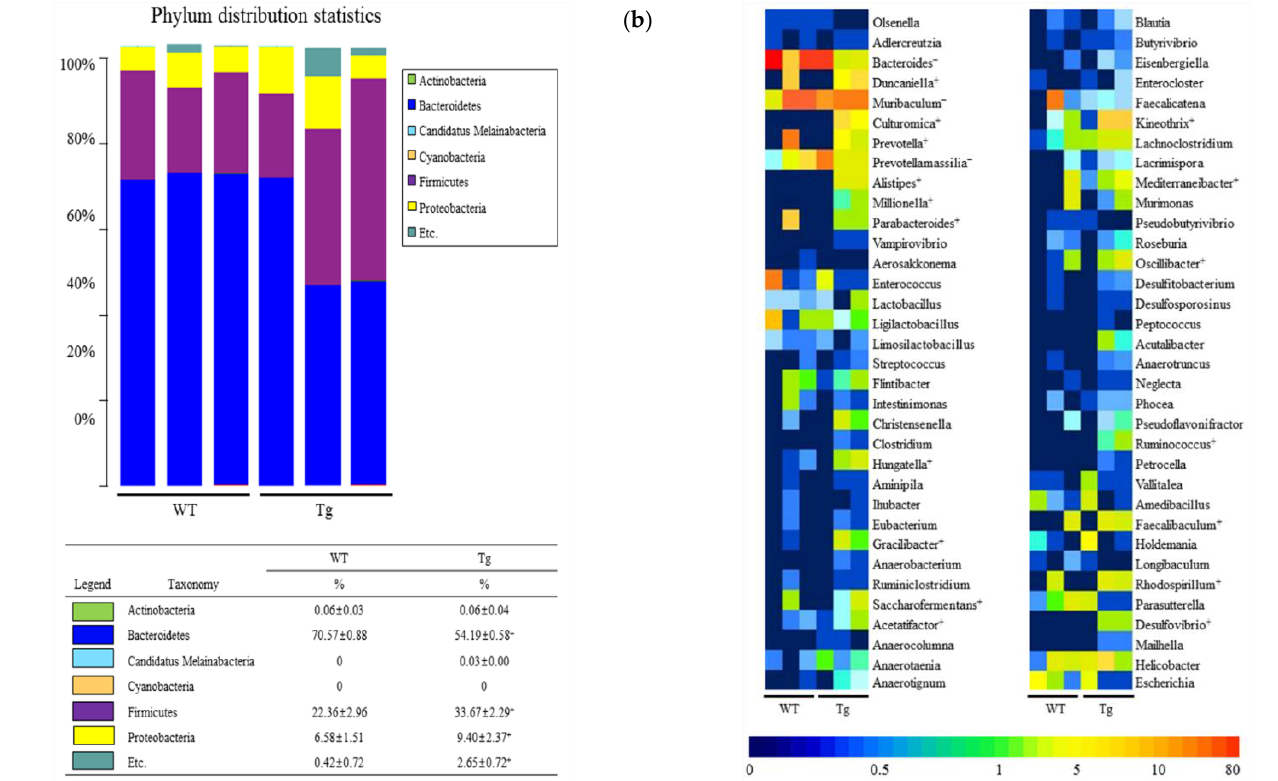
Figure 2. Profile of fecal microbiota. ( a ) Heat map showing the fecal microbiota distribution at the phylum level. Different colors in the heat map indicate the relative abundance of each phylum. ( b ) Heat map showing fecal microbiota distribution at the genus level. Different colors in the heat map indicate the relative abundance of each genus. The data are reported as the mean ± SD values. “ − ” represents a decrease compared to the WT mice; “ + ” represents an increase compared to the WT mice. Abbreviations: WT, wild-type; Tg, Tg2576 mice.